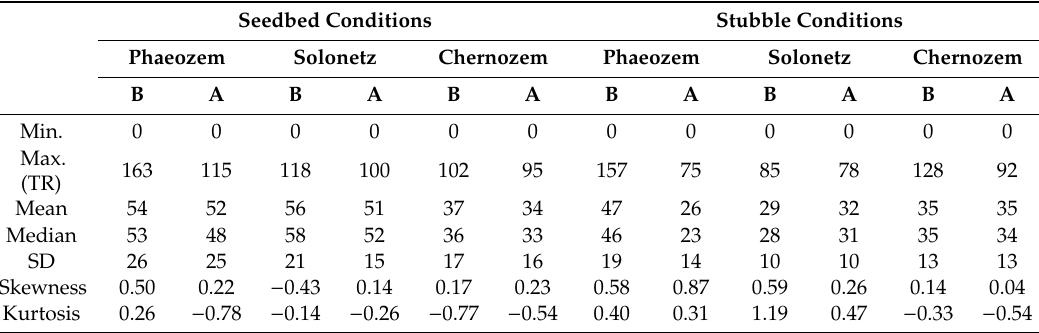
Table 3. Surface roughness changes due to rainfall simulation based on the elevation model histograms. The values are in mm, TR: topographic range, B: before precipitation; A: after precipitation, SD: standard